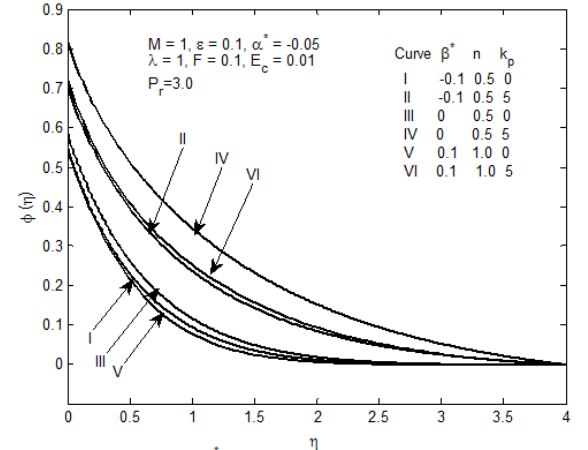
Figure 16: Temperature profiles (PHF case)